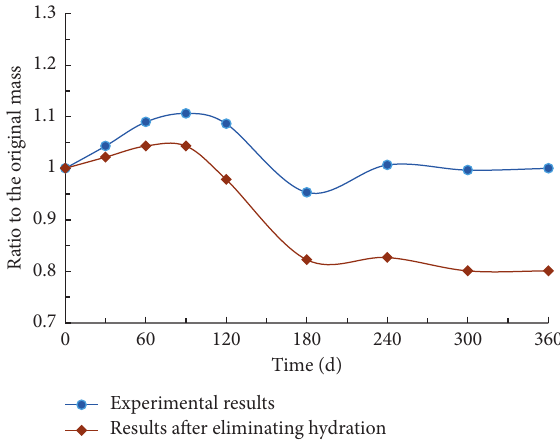
Figure 3: Variation of compressive strength and elasticity modulus of CGB soaked in AMD.